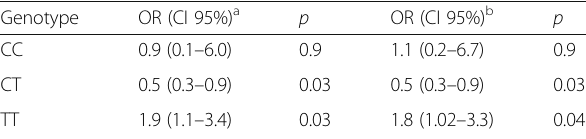
Table 4 Multivariate analysis results of rs731236 for Mexican cases with osteoarthritis of the knee and controls